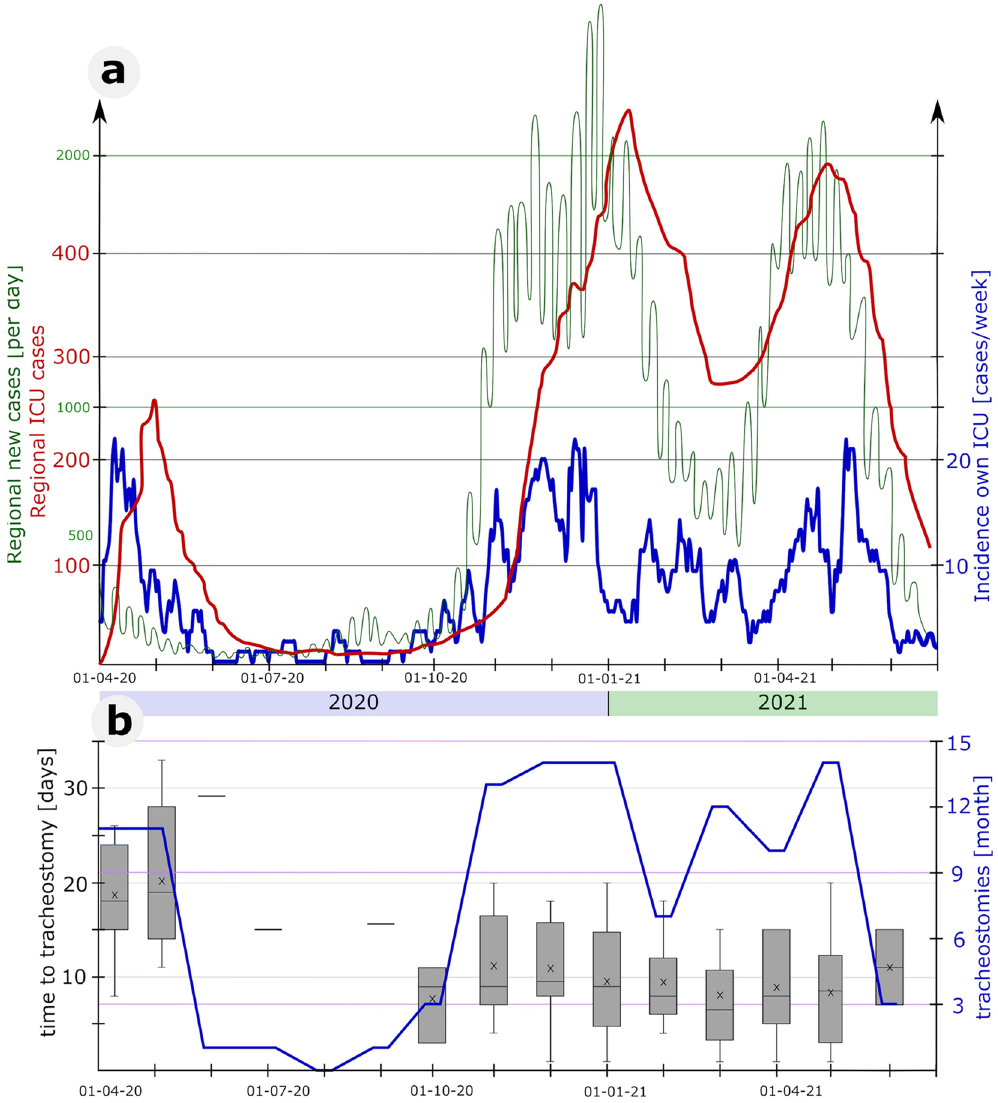
Figure 2. Caseload and tracheostomies through observation period. ( a ) New COVID-19 cases reported daily in the federal state of Hessen (Germany) (green) and corresponding patients treated in ICUs in Hessen (red), as well as course of own ICU admissions per week (blue) 52 . ( b ) Number of COVID-19 tracheostomies performed per month (blue) and invasive ventilation time until tracheostomy, shown as a boxplot whisker plot (grey). ICU, intensive care